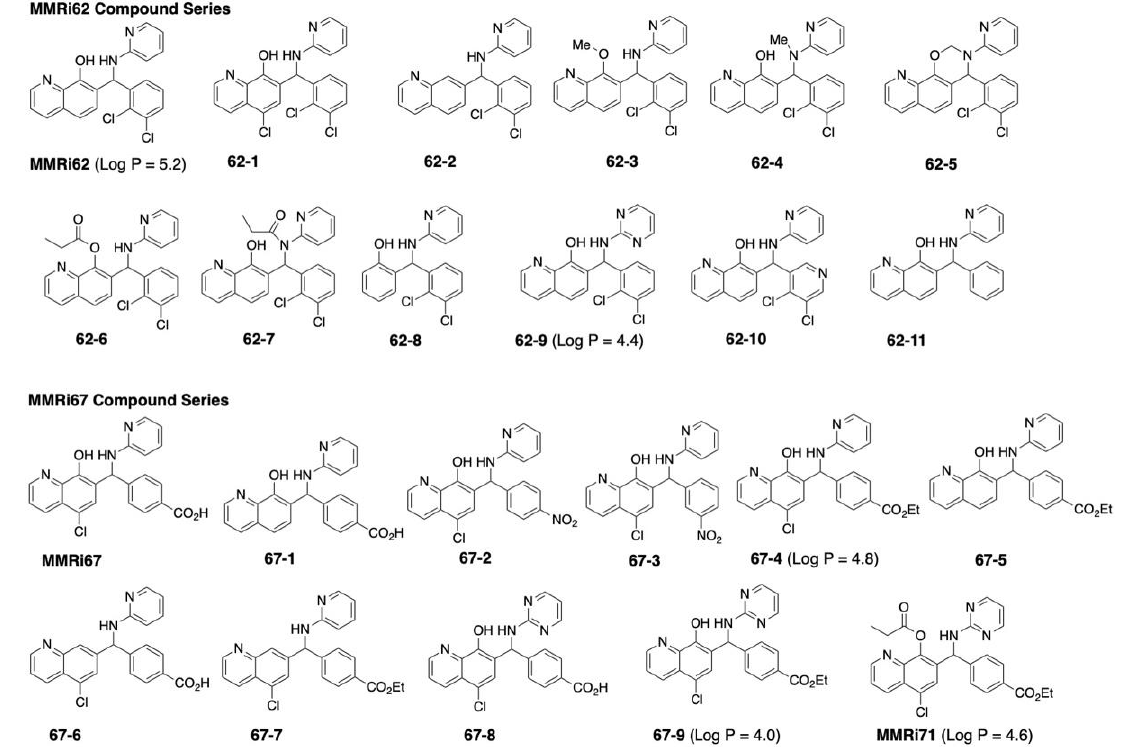
Figure 1. Structures of MMRi62 and MMRi67 compound series.